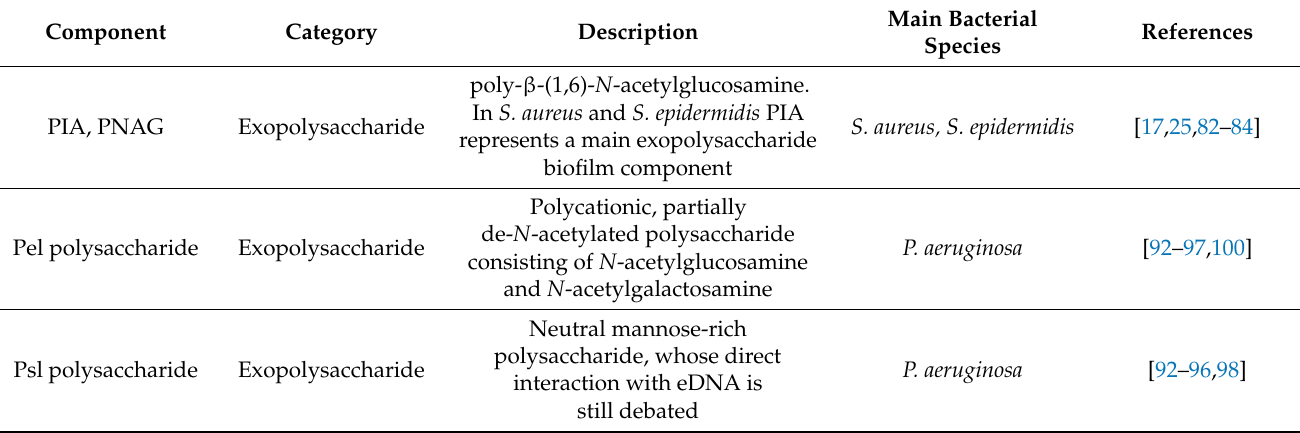
Table 1. Polysaccharides interacting with eDNA in the biofilm